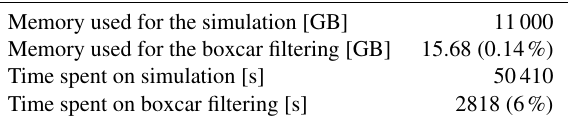
Table 1. Profiling statistics for the boxcar filtering operator.